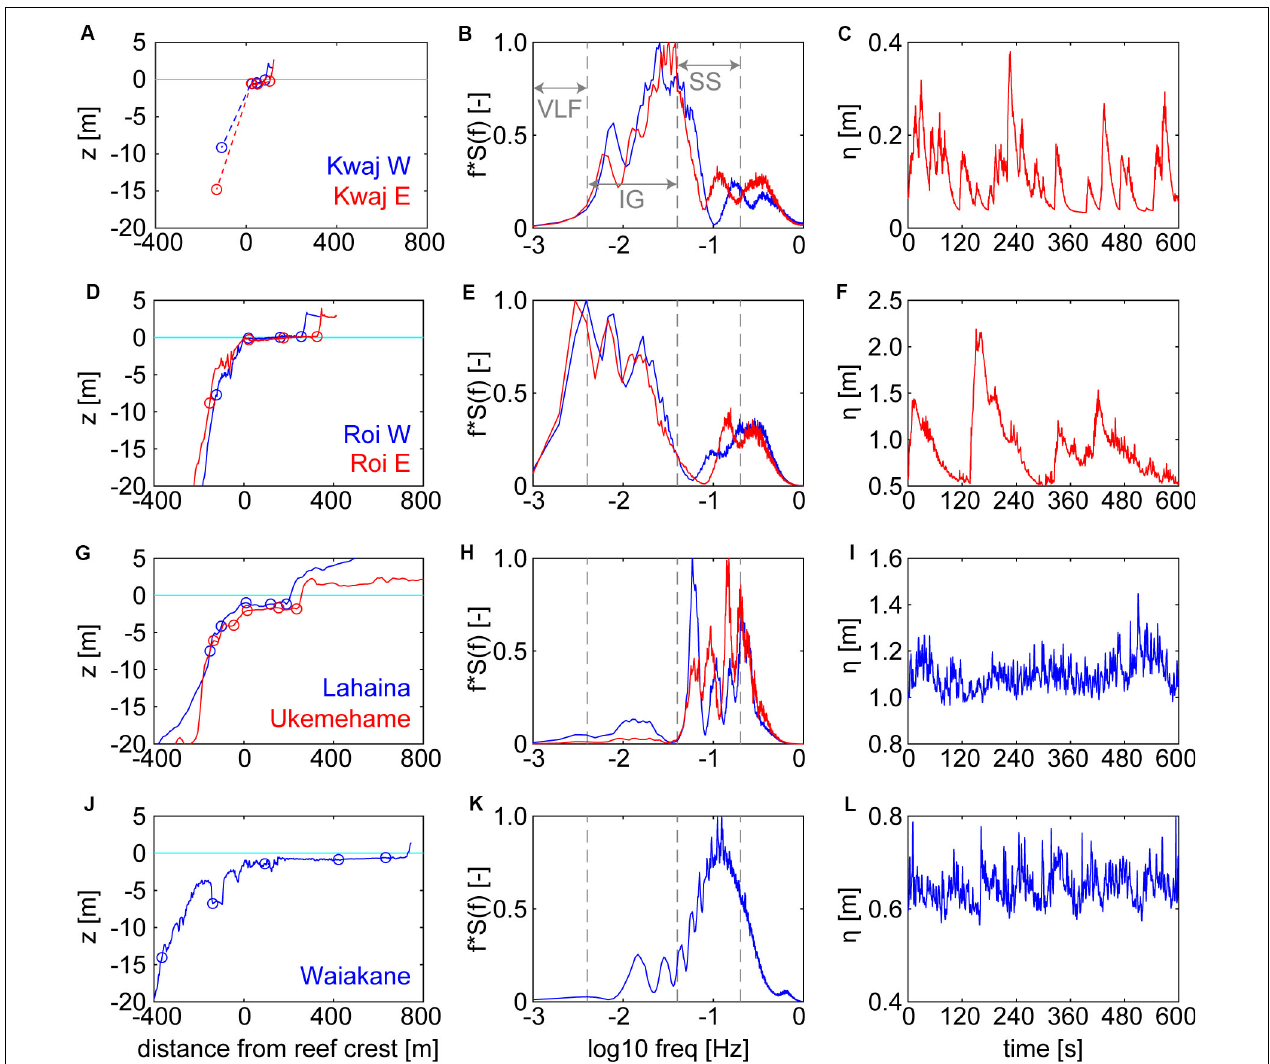
FIGURE 1 | Varying reef geometries, and the subsequent wave energy partitioning and wave characteristics. (A,D,G,J) Reef bathymetric profiles and sensor locations (circles) with distance from the reef crest (positive is toward shore) and colors corresponding to sites. For Kwajalein reefs, the dashed line indicates region where no bathymetry was available. (B,E,H,K) Mean variance-preserved energy density spectra from the inner reef-flat sites, normalized by the maximum mean energy; colors correspond to sites in left-hand column. Gray vertical dashed lines indicate frequency bands of sea-swell (SS), infragravity (IG), and very-low frequency (VLF) waves. (C,F,I,L) examples of 600 s time series for water levels to show the types of irregular waves at each site; for rows that display two sites, only one example is shown for clarity, but it is representative of the wave character at the site not